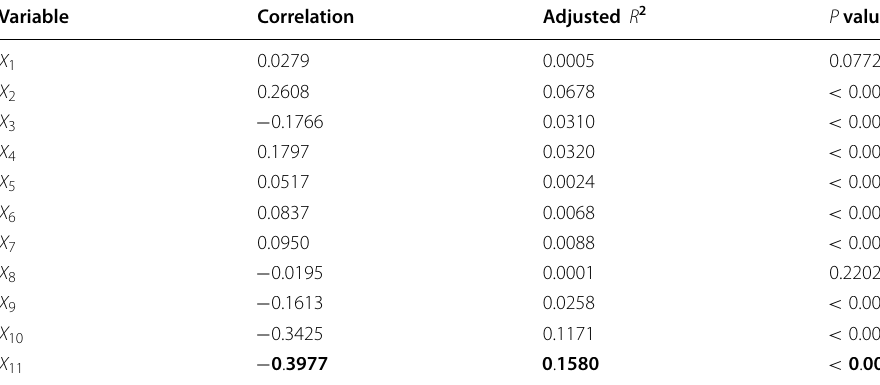
The statistic is considered significant when its P -value is less than 0.05